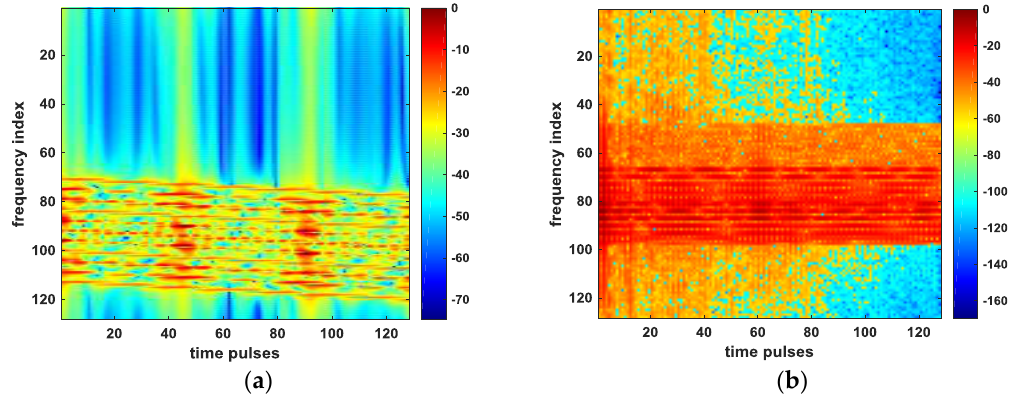
Figure 9. Spectrograms of time pulses. ( a ) before applying the proposed method; ( b ) after applying the proposed method.